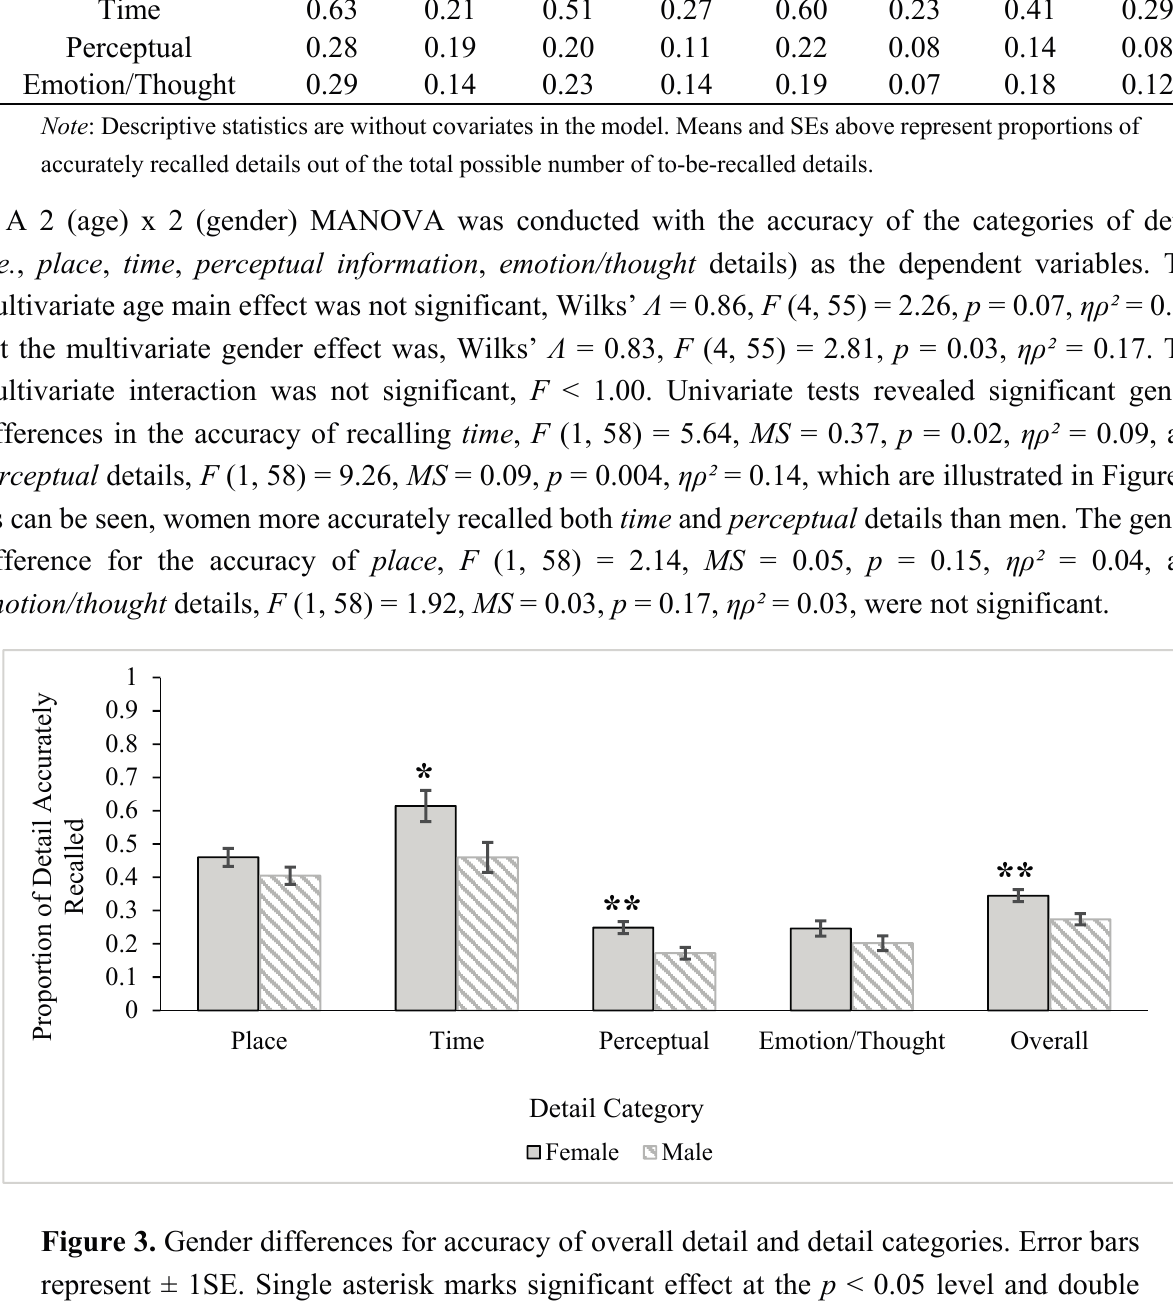
Detail Accuracy